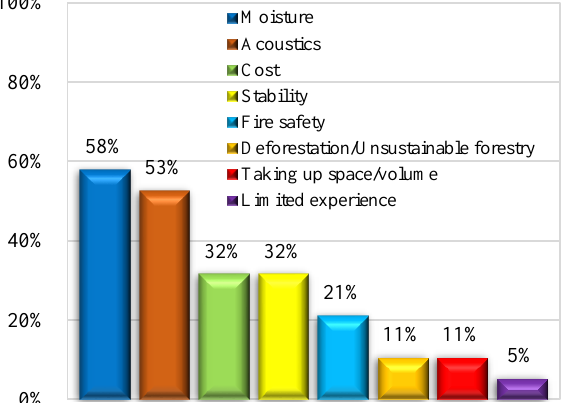
Figure 10. Comparison of disadvantages of constructing with wooden frames considered by ERs and UERs.